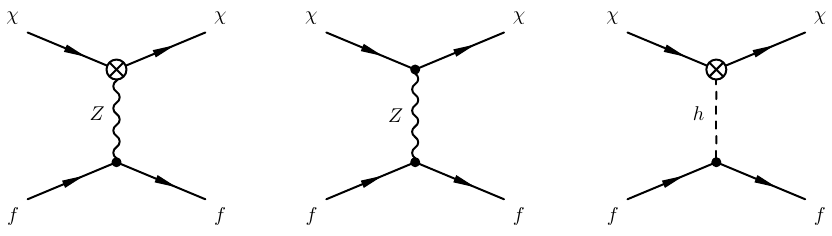
m Z . The left diagram shows (cid:24)